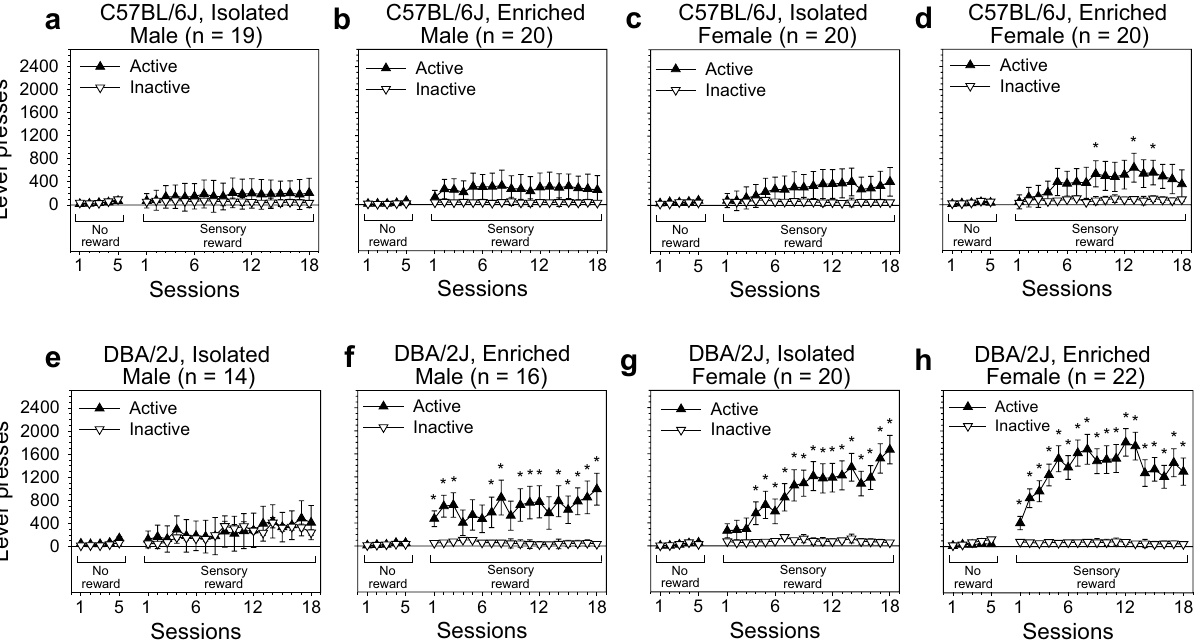
Figure 1. OSS acquisition curves for male and female C57BL/6J and DBA/2J mice that were housed long-term in one of two housing conditions: isolation or environmental enrichment. (a – d) OSS acquisition curves for male and female C57BL/6J mice in the isolation and enrichment conditions. (e , f) OSS acquisition curves for male and female DBA/2J mice in the isolation and enrichment conditions. * p <